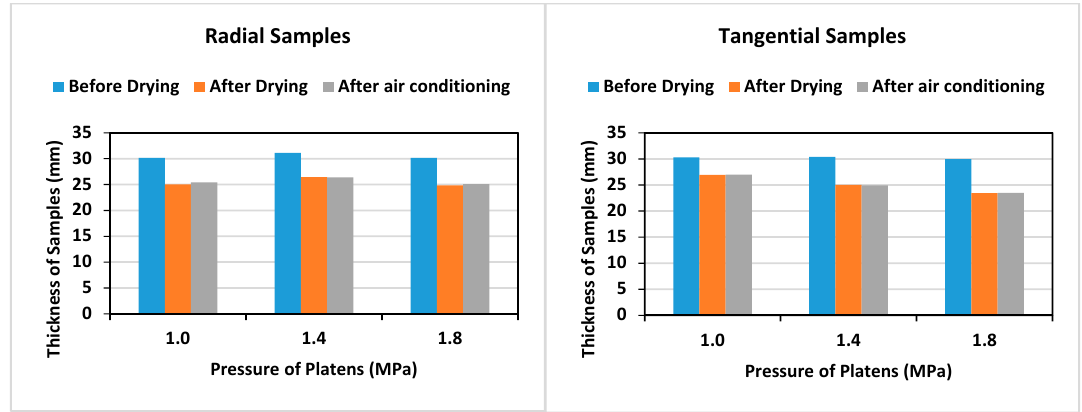
Figure 8. Average values of the sample thickness before drying, after drying and after air conditioning.